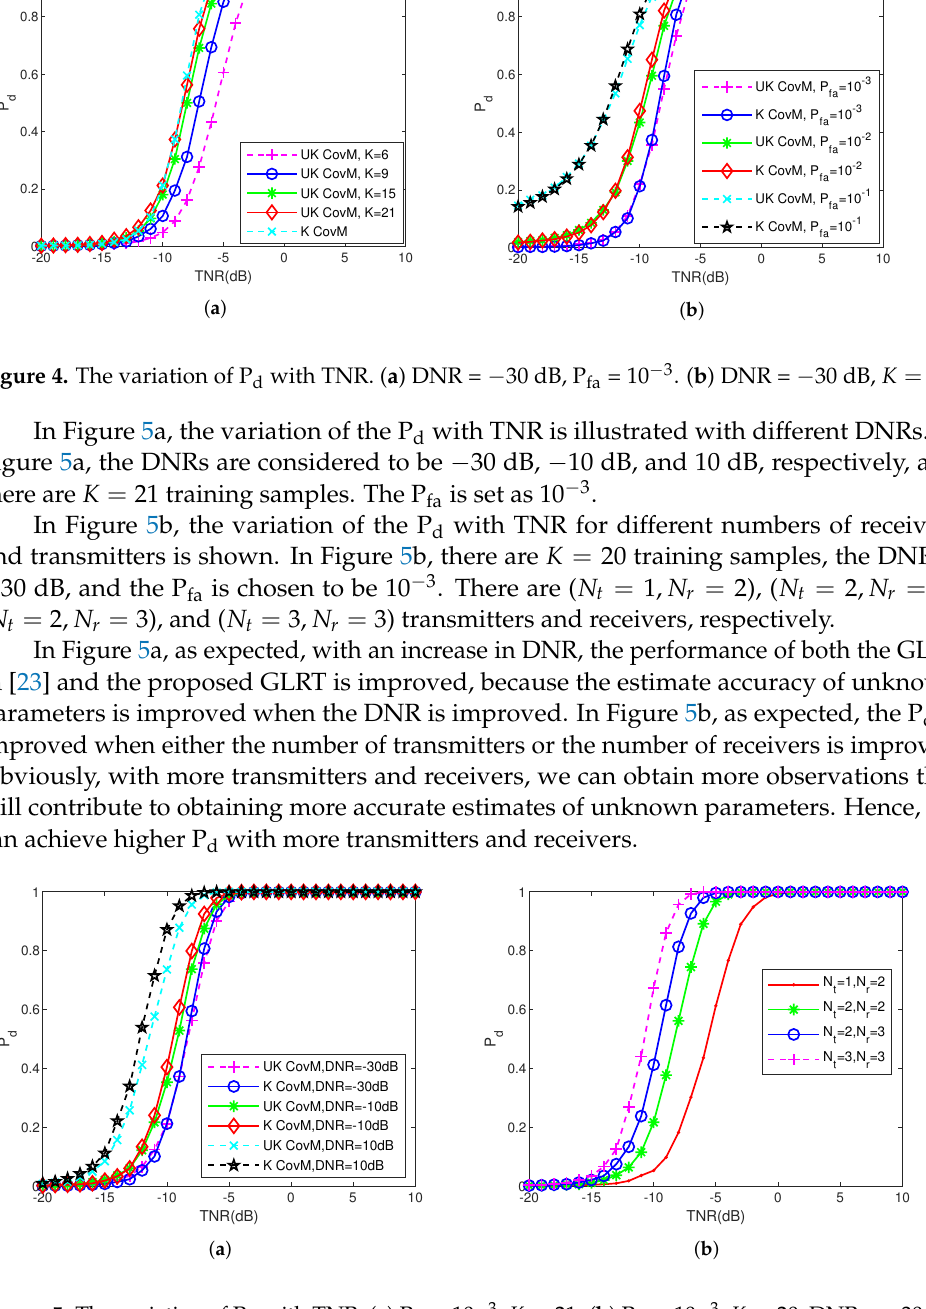
Figure 5. The variation of P d with TNR. ( a ) P fa = 10 − 3 , K = 21. ( b ) P fa = 10 − 3 , K = 20, DNR = − 30